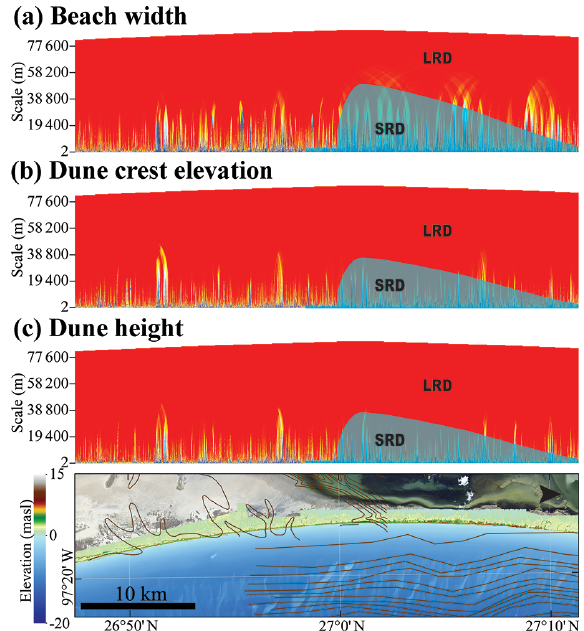
Figure 5. LRD plots of (a) beach width, (b) dune crest elevation, and (c) dune height for central PAIS, where Fisk (1959) identified a series of relict infilled paleo-channels dissecting the island. The scale at which LRD breaks down in favor of SRD is greatest at the southern edge of large paleo-channels, and this scale gradually decreases to the north. Smaller paleo-channels do not appear to be as influential in the modern beach and dune morphology, suggesting that small channels may not have as significant an influence as larger